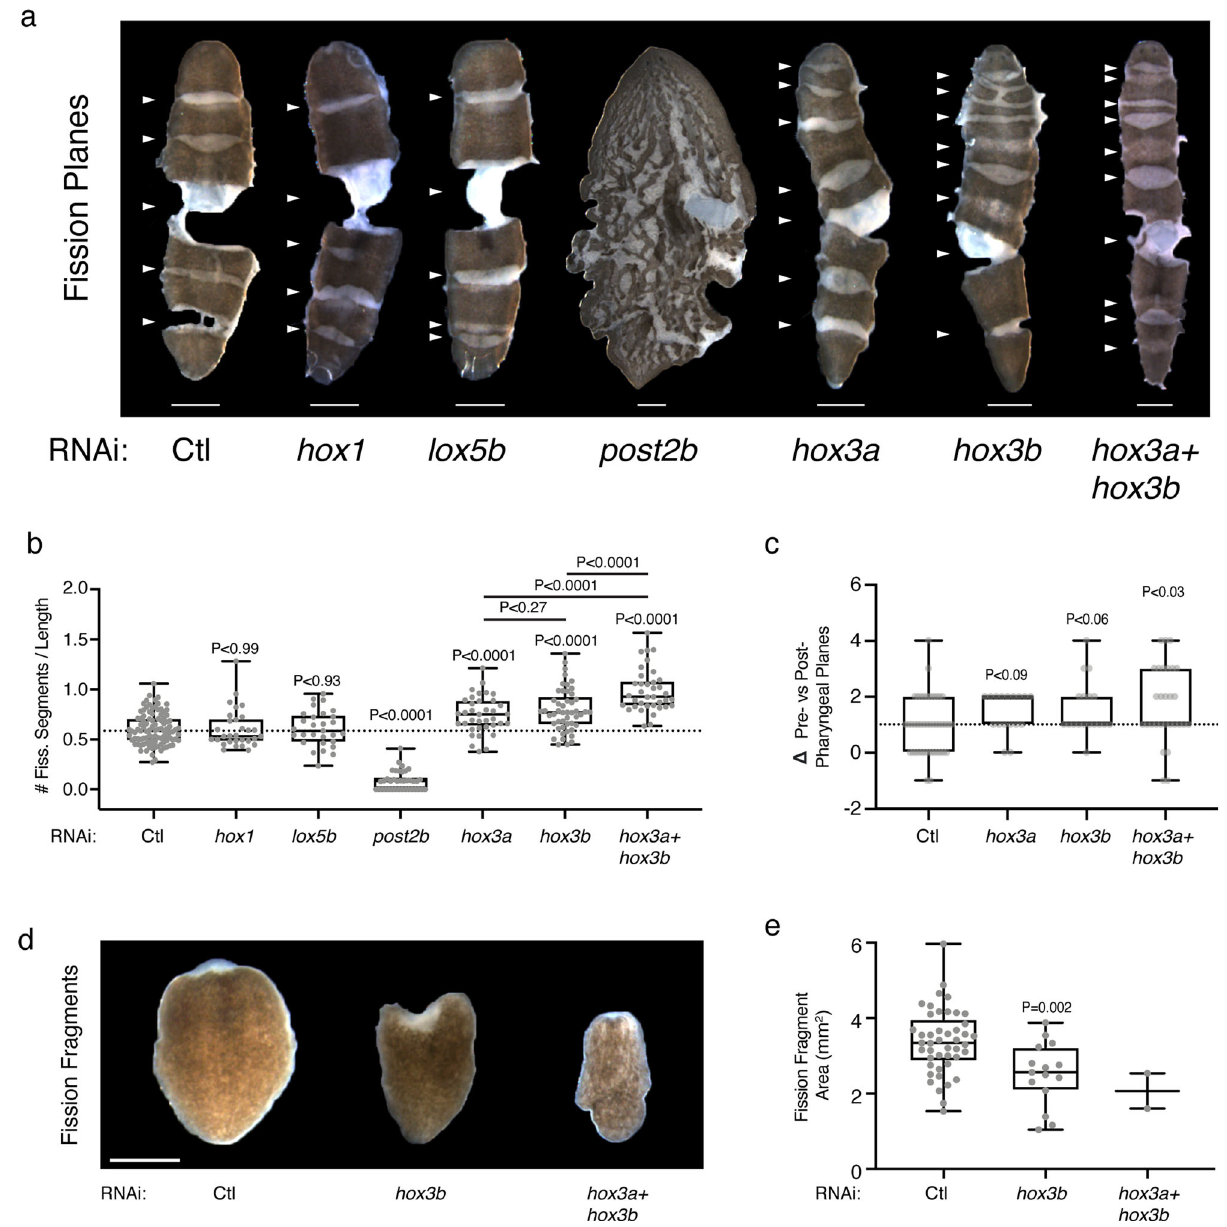
Fig. 2 post2b and hox3 are opposing regulators of adult tissue segmentation. a Representative images of RNAi animals compressed to reveal fi ssion planes and segmentation (arrows indicate fi ssion planes). b Plot of the number of fi ssion planes/animal length following Hox RNAi treatment ( n = 100, 30, 29, 38, 37 49, and 37 animals for Ctl, hox1 , lox5b , post2b , hox3a , hox3b , and hox3a + hox3b RNAi samples, respectively; Ctl vs. hox1 , lox5b , post2b , hox3a , hox3b , and hox3a + hox3b p -values = 0.9844, 0.9234, <0.0001, <0.0001, <0.0001, and <0.0001, respectively; hox3a vs. hox3b and hox3a + hox3b p -values = 0.2696 and <0.0001, respectively; hox3b vs. hox3a + hox3b p -value is <0.0001; sample replicates pooled from two independent experiments with eight dsRNA feedings or 17 bacterial RNAi feedings; at least two independent repeats for each RNAi conditions). c Plot of the difference between the number of pre-pharyngeal vs. post-pharyngeal fi ssion planes following RNAi treatment ( n = 41, 17, 18, and 29 animals for Ctl, hox3a , hox3b , and hox3a + hox3b RNAi samples, respectively; Ctl vs. hox3a , hox3b , and hox3a + hox3b p -values = 0.0876, 0.0568, 0.0257; 17 bacterial RNAi feedings). d Representative images of fi ssion progeny following RNAi treatment. e Plot of surface area of fi ssion progeny ( n = 45, 15, and 2 fi ssion progeny for Ctl, hox3b , and hox3ab RNAi samples, respectively; Ctl vs. hox3b p -value = 0.002; 17 bacterial RNAi feedings). p -values were calculated by Welch ’ s two-tailed t - test. Scale, 1 mm. Box and whisker plot depicts individual data points, median (center), 25th/75th percentile (bounds of box), and minima/maxima (whiskers). Source data are provided as a Source Data fi